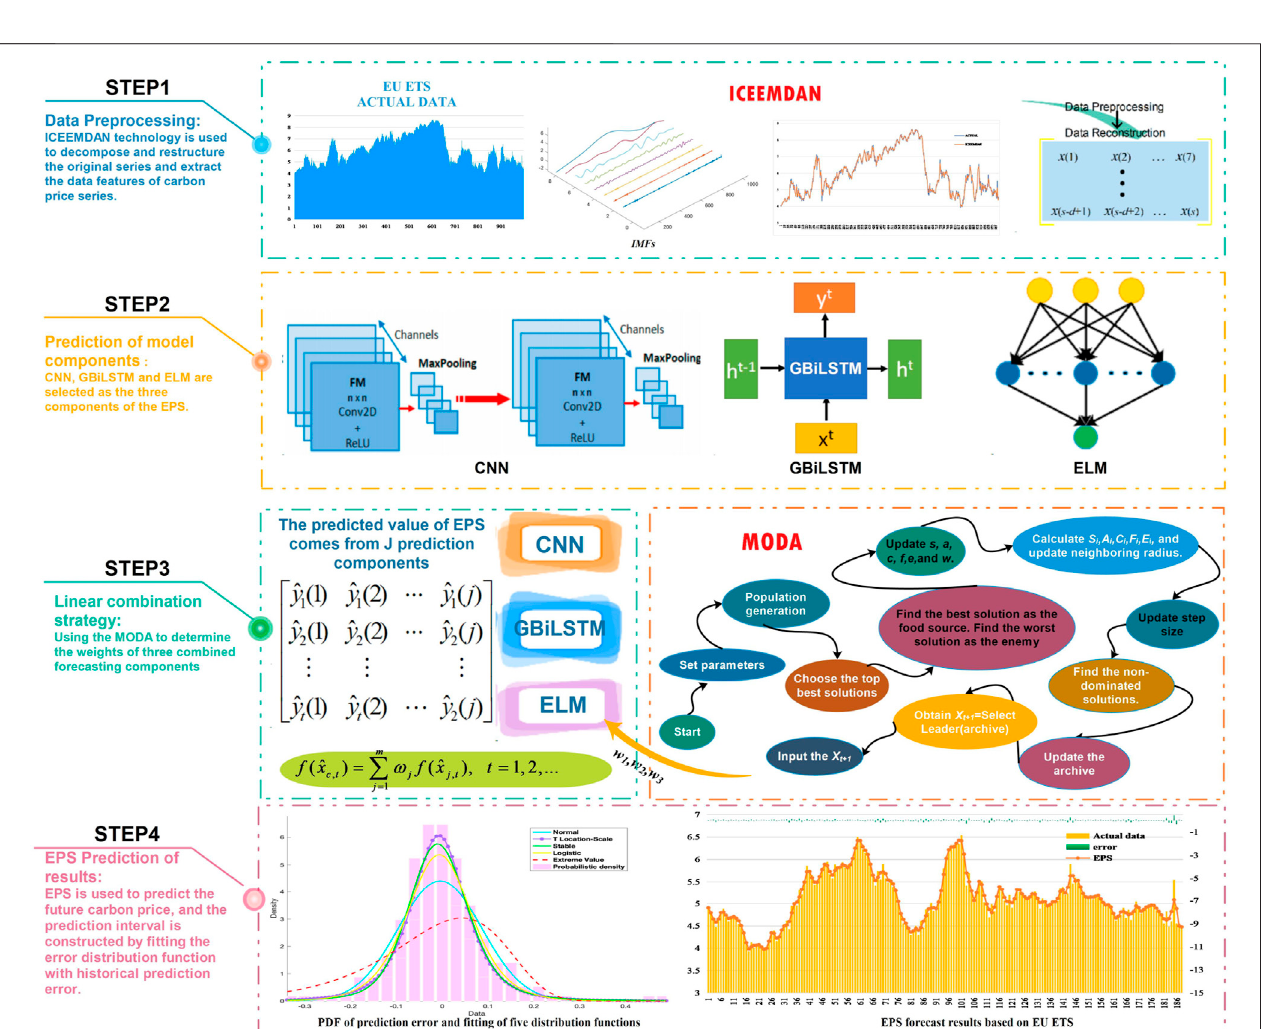
FIGURE 2 | EPS system and its interval prediction model